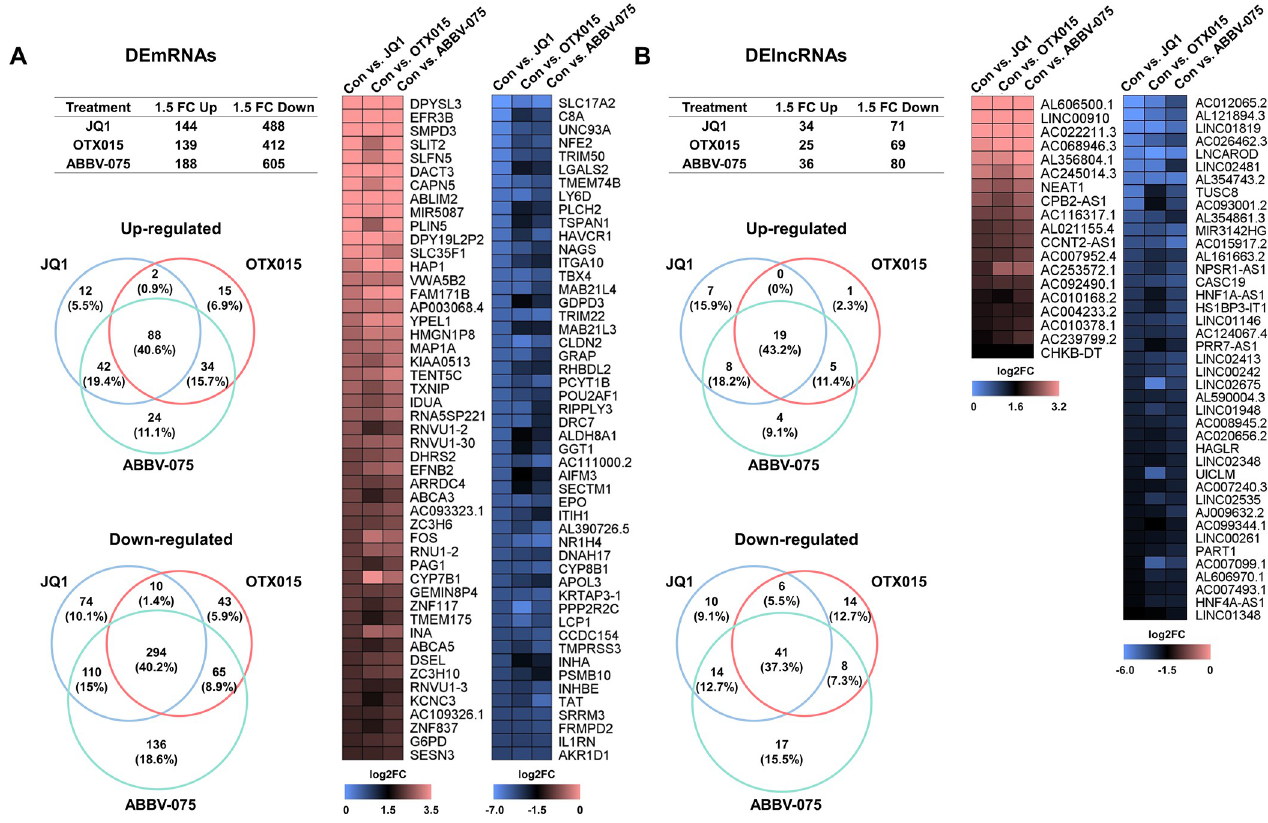
Fig 2. Identification of DEmRNAs and